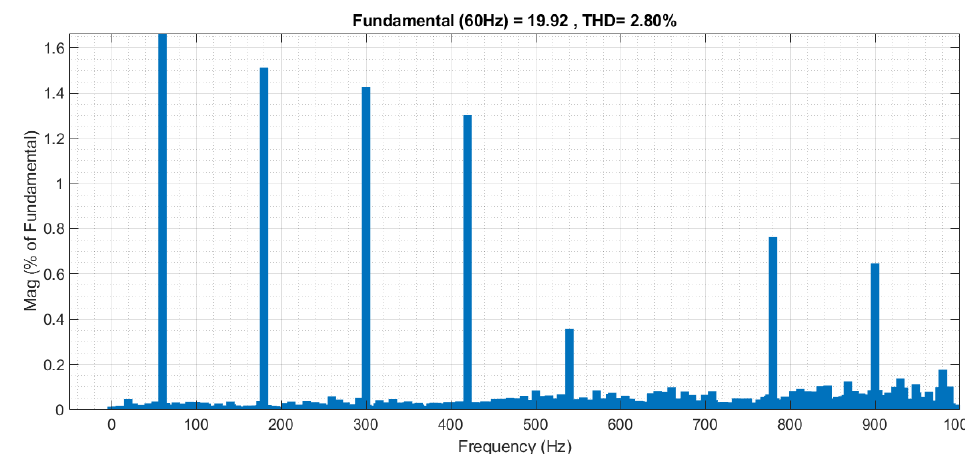
Figure 12. Rate harmonic distortion I S after compensation.